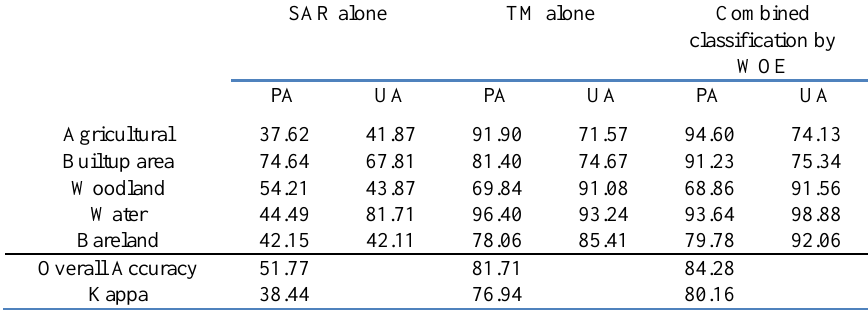
Table 1 Classification results using different data for Beijing area (all in percent)